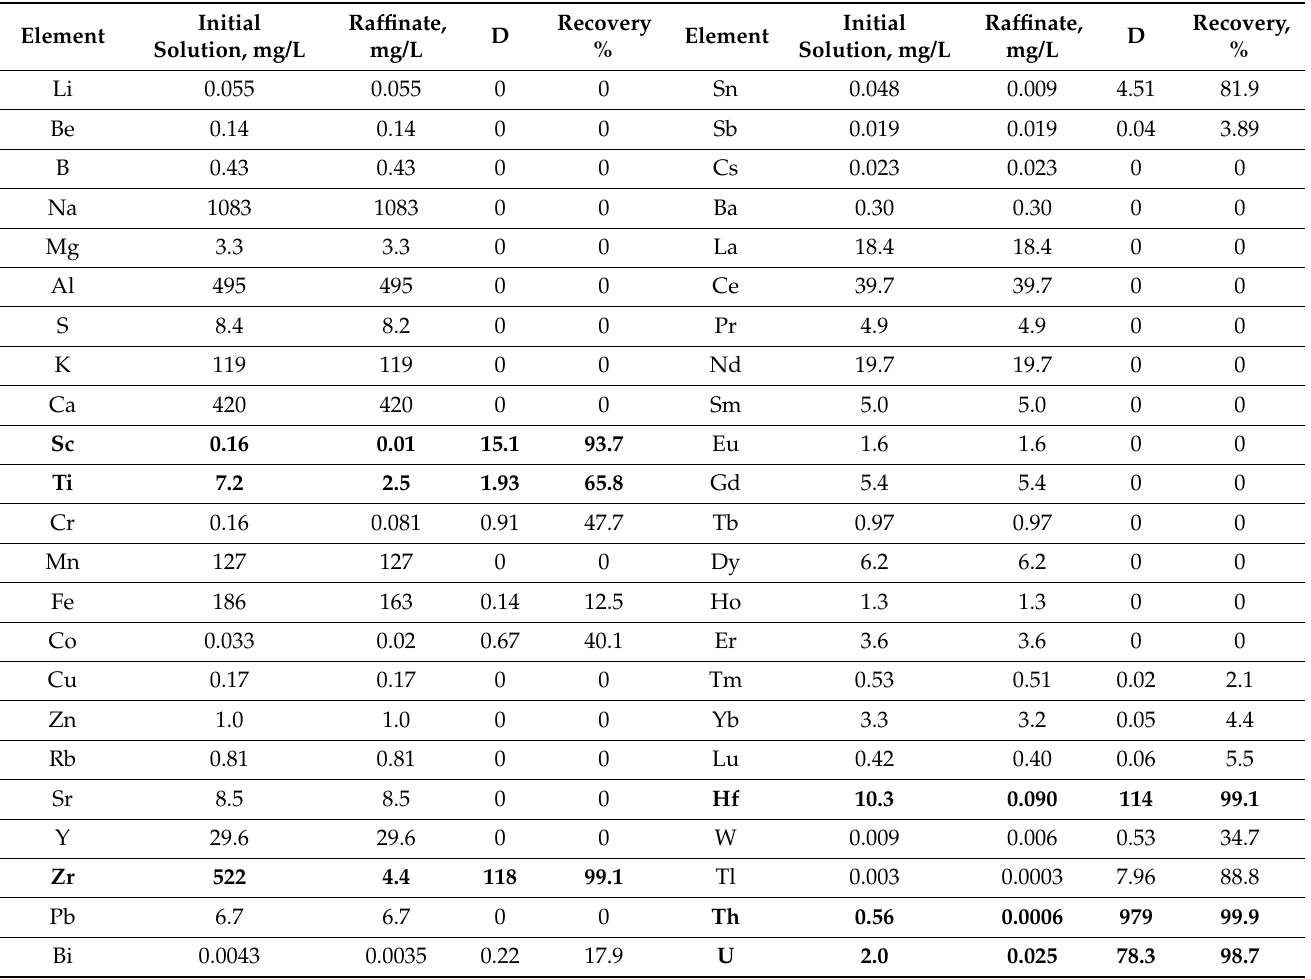
Table 5. Results of a single metal recovery stage from the eudialyte breakdown solution by